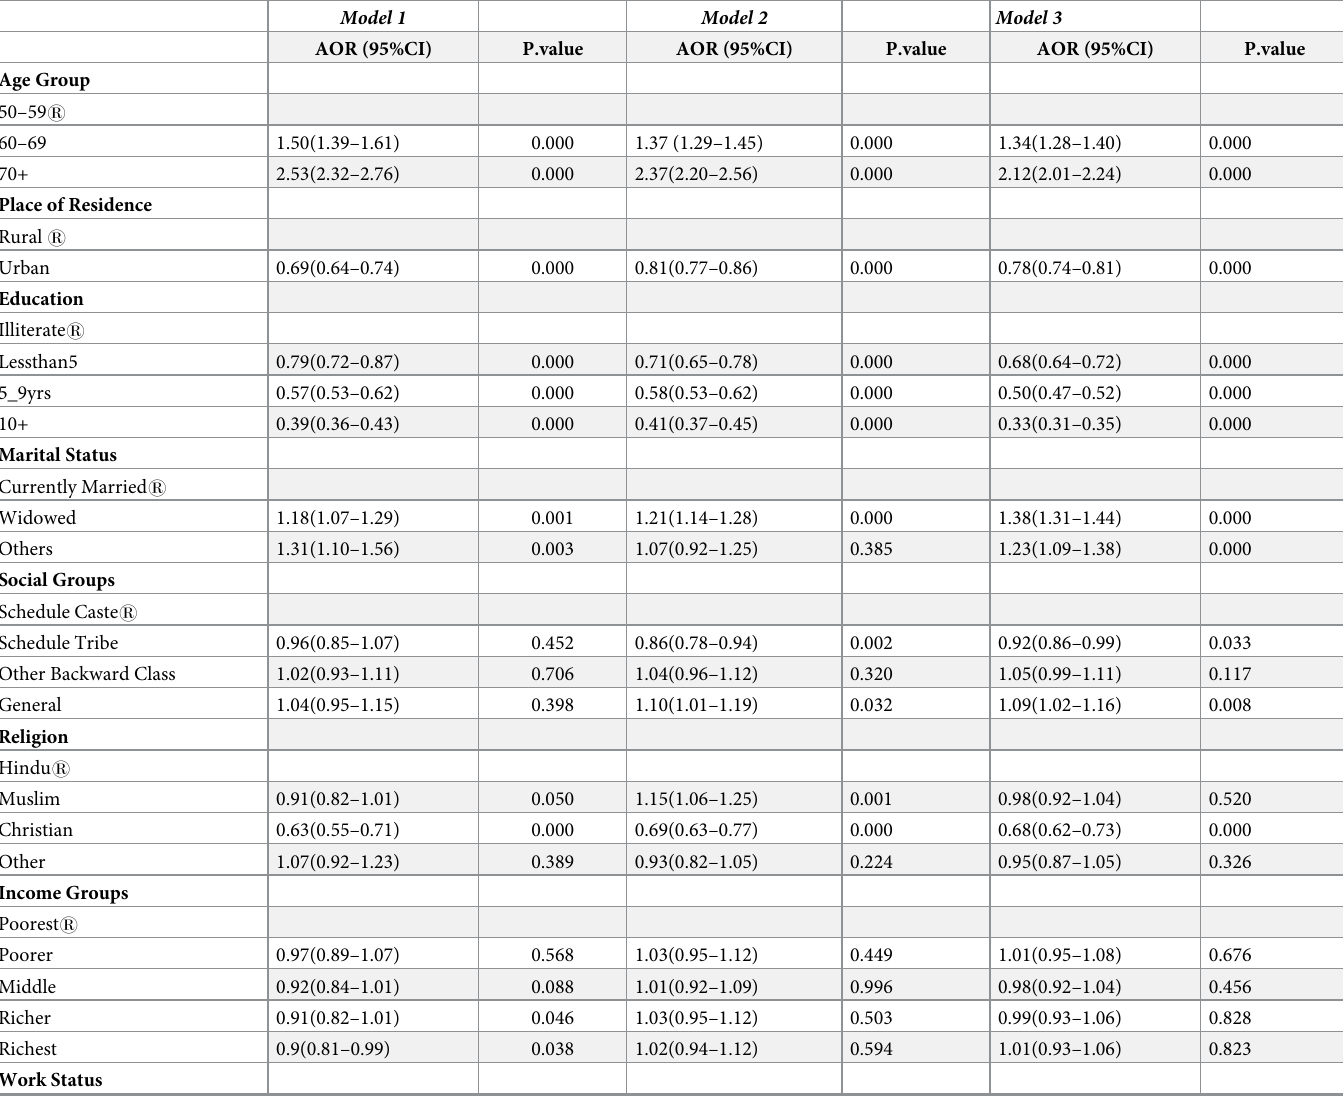
Table 3. Predictors of functional disability using adjusted odds ratio by gender and overall among older adults aged 50 and above in